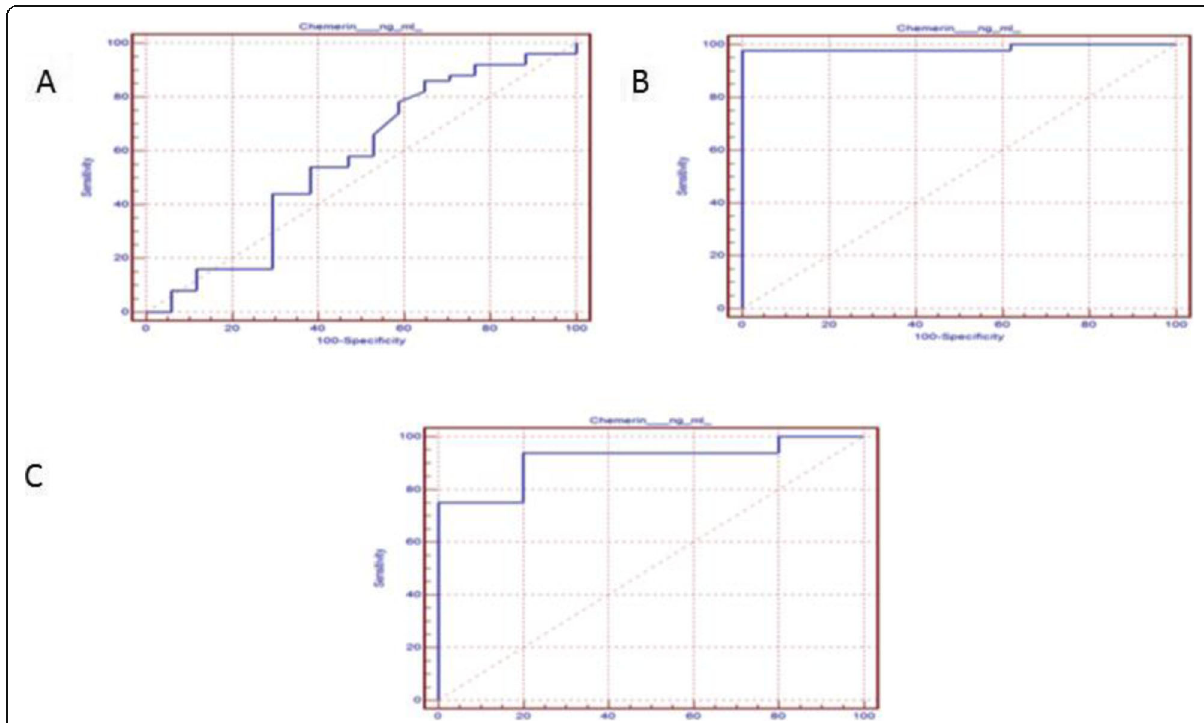
Fig. 3 Receiver operating characteristic (ROC) curve analysis was done for diagnostic performance of chemerin (ng/ml). a Diagnostic performance of chemerin (ng/ml) in discrimination of metabolic syndrome (MetS) group vs control, b T2DM subgroup and non-diabetic. c Known diabetics and NDM (newly diagnosed